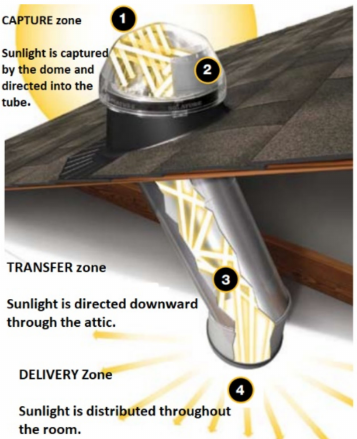
Figure 6. Solatube daylighting system. Adapted from ref. [83].